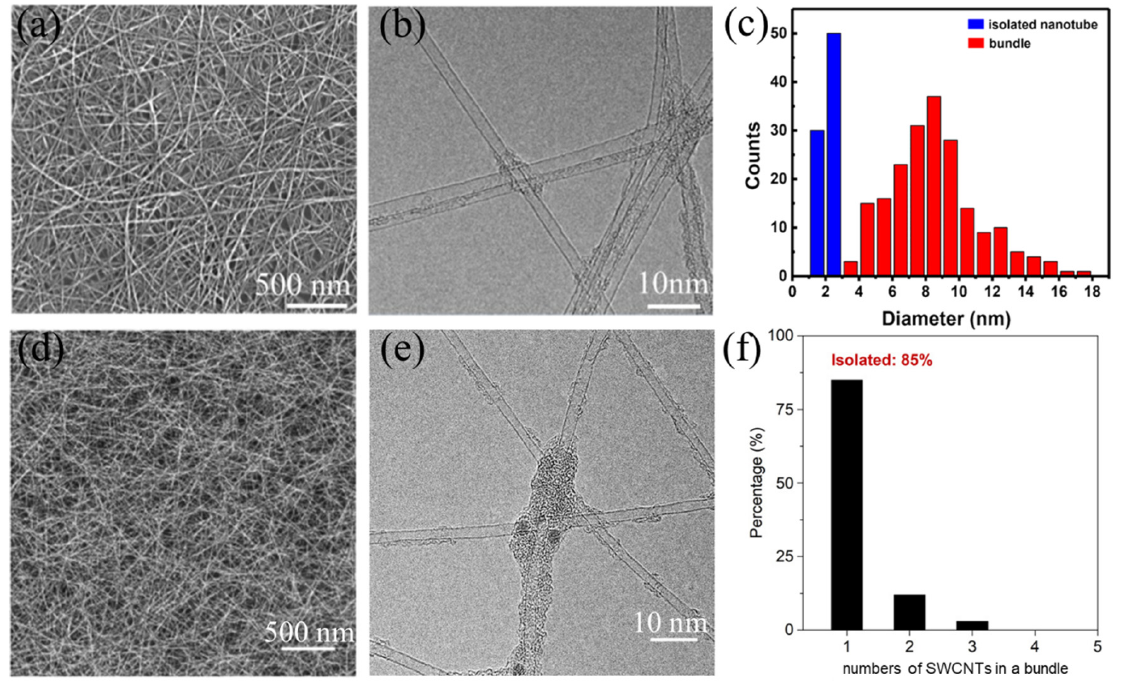
Figure 6. Microstructures of small-bundle [74] SWCNTs ( a – c ) and isolated [75] SWCNTs ( d – f ) with carbon-welded joints. ( a , d ) Typical SEM images. ( b , e ) Typical TEM images. ( c , f ) Statistical data of the numbers of isolated and bundled SWCNTs in the network. Reproduced with permission from Ref. [74]. Copyright 2018 Elsevier, and Reproduced with permission from Ref. [75]. Copyright 2018, American Association for the Advancement of Sciences.